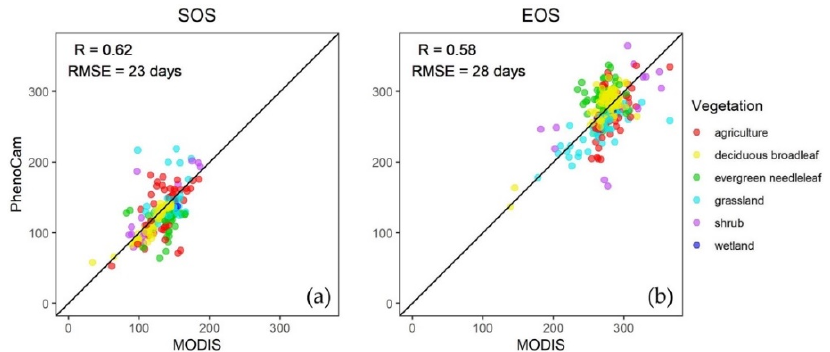
Figure 6. The correlation between Landsat and PhenoCam ( a ) SOS and ( b ) EOS DOY over 2016–2018.